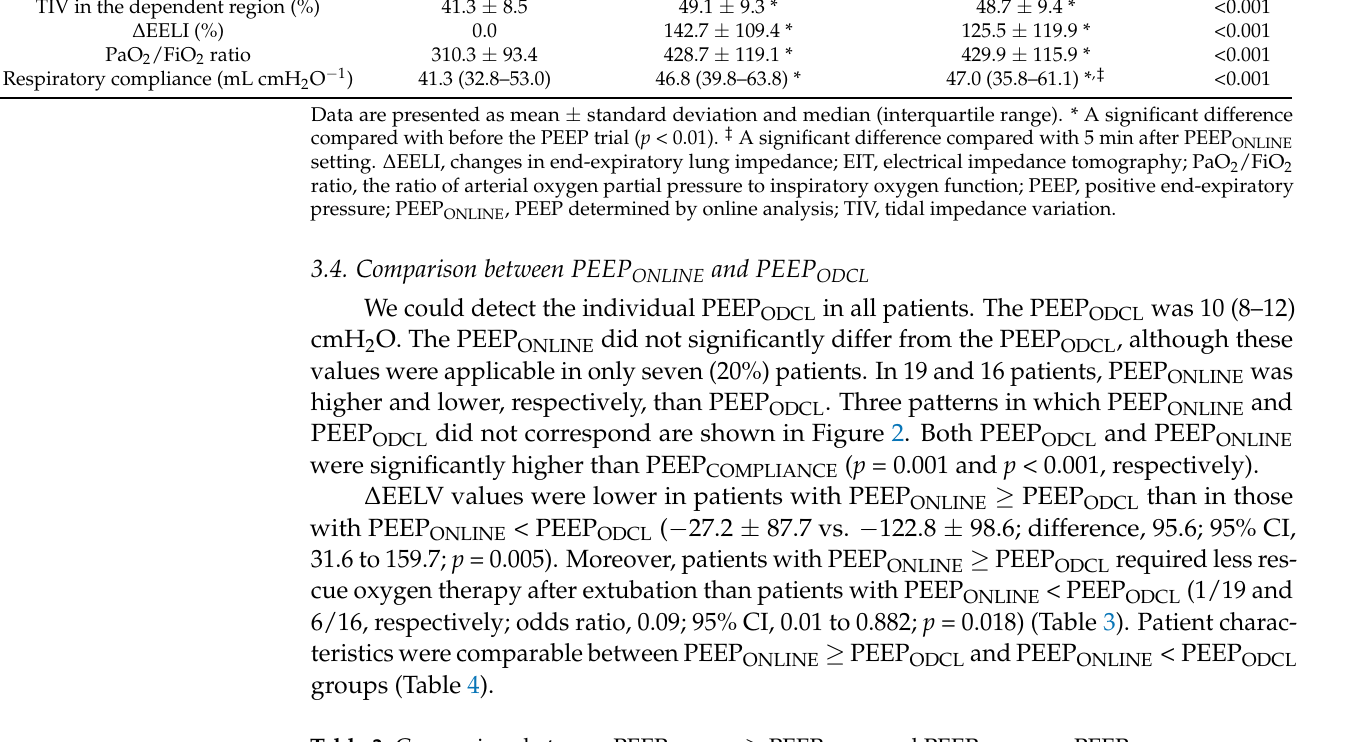
Table 3. Comparison between PEEP ONLINE ≥ PEEP ODCL and PEEP ONLINE < PEEP ODCL